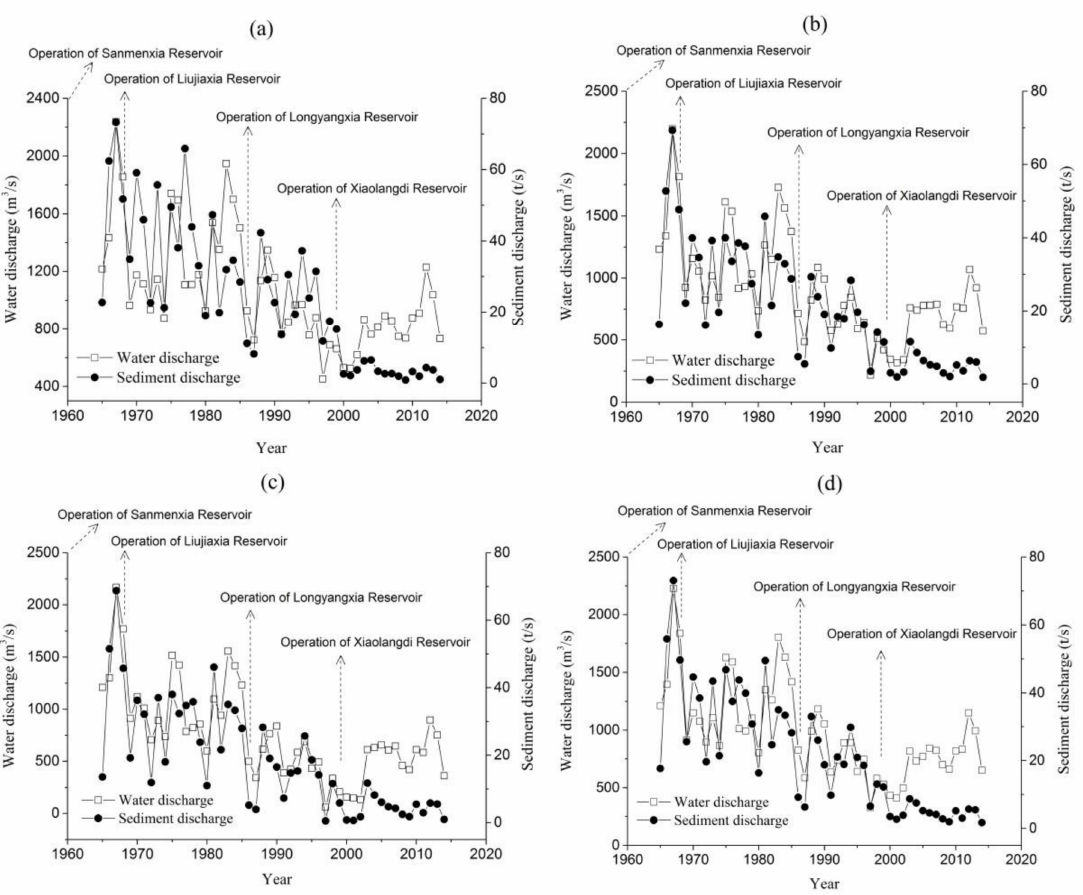
Figure 3. The annual mean water and sediment discharges at Huayuankou ( a ), Gaocun ( b ), Luokou ( c ) and Lijin ( d ) stations in the lower Yellow